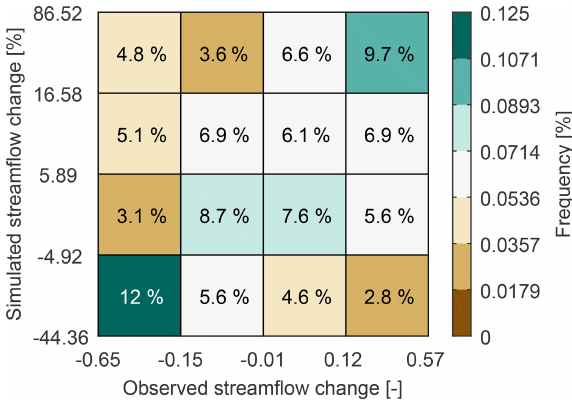
Figure 6. Two-dimensional quartile distribution of observed ver- sus simulated streamflow. Note that observed streamflow changes are normalized by interannual streamflow variability, whereas sim- ulated changes are normalized by their 1960s values.